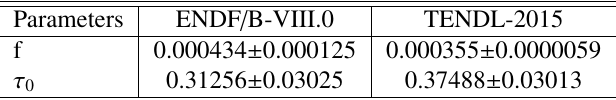
Table 1. S -process strong component neutron fluence parameters for ENDF / B-VIII.0 and TENDL-2015 libraries [15,